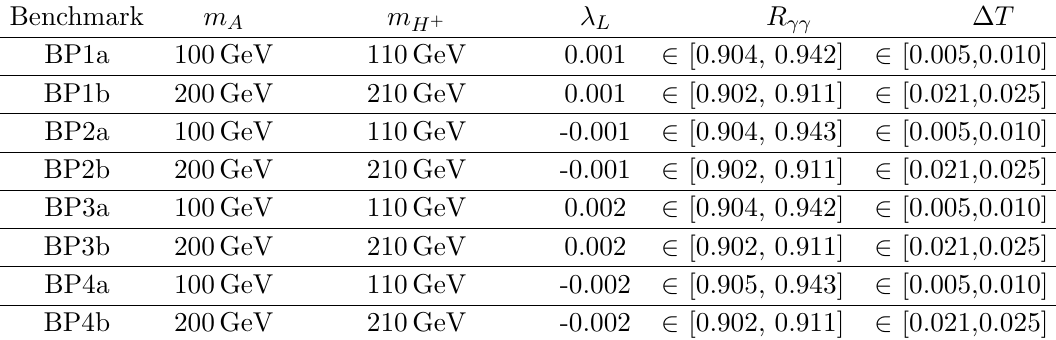
Table 1 . Benchmark points, 50 GeV < m H < 80 GeV, satisfying the constraints listed in sec- tion 3, chosen to illustrate the e(cid:11)ect of the one-loop corrections. The same benchmarks can also be expressed in terms of the corresponding (cid:22) 2 values using m 2 variations of (cid:1) T and R (cid:13)(cid:13) are also